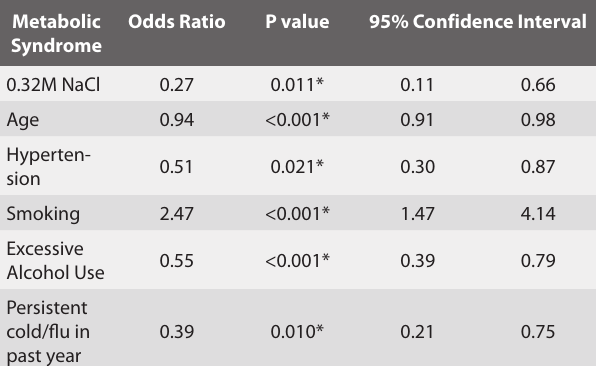
Table 6. Summary of significant associations found between smell and taste dysfunction and obesity and metabolic